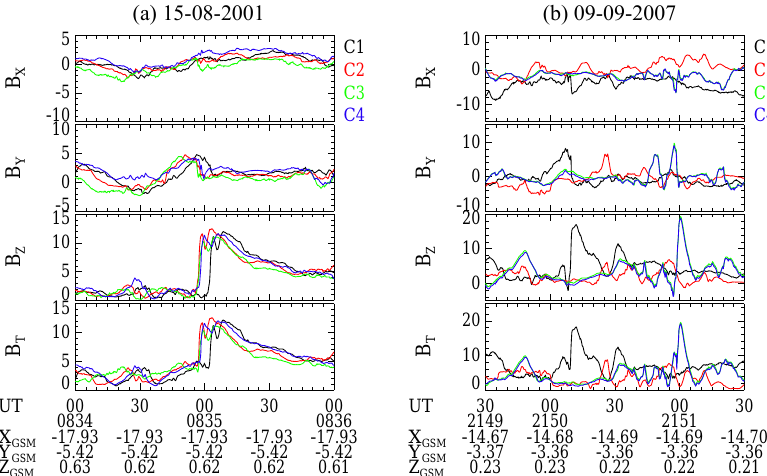
Figure 3. The magnetic field data of two DF events on 15 August 2001 (a) and 9 September 2007 (b) . Black, red, green, and blue colors indicate data from C1, C2, C3, and C4, respectively.